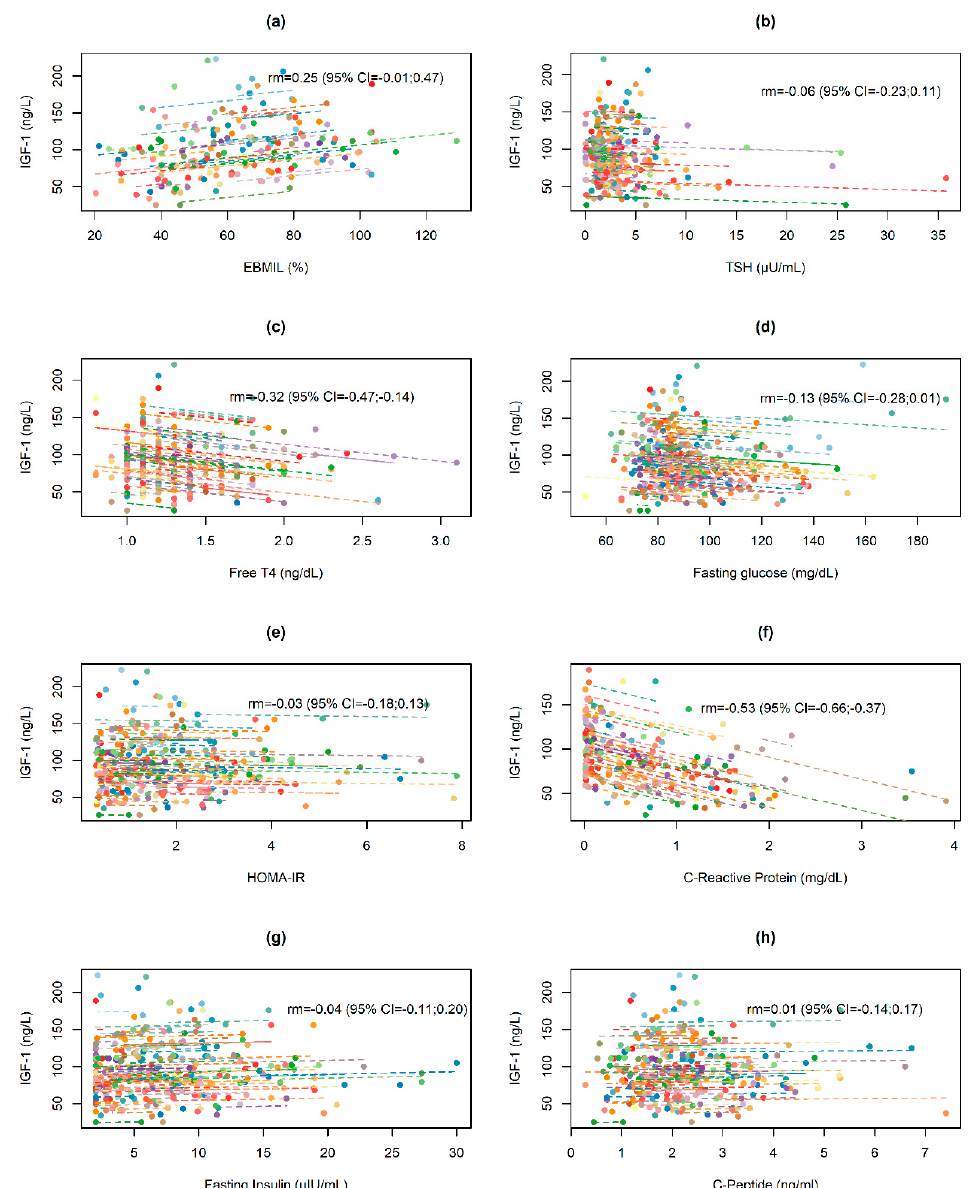
Figure 3. Repeated measures correlation for the overall relationship between changes in IGF-1 and ( a ) excessive BMI loss (EBMIL), ( b ) TSH, ( c ) free T4, ( d ) fasting glucose, ( e ) HOMA-IR, ( f ) C-reactive protein, ( g ) fasting insulin and ( h ) C-peptide. Obese subjects are represented by points that correspond to pre- and post-operative IGF-1 levels and the respective anthropometric, biochemical and hormonal data. Each line represents the correlation adjustment of repeated measures for each participant.